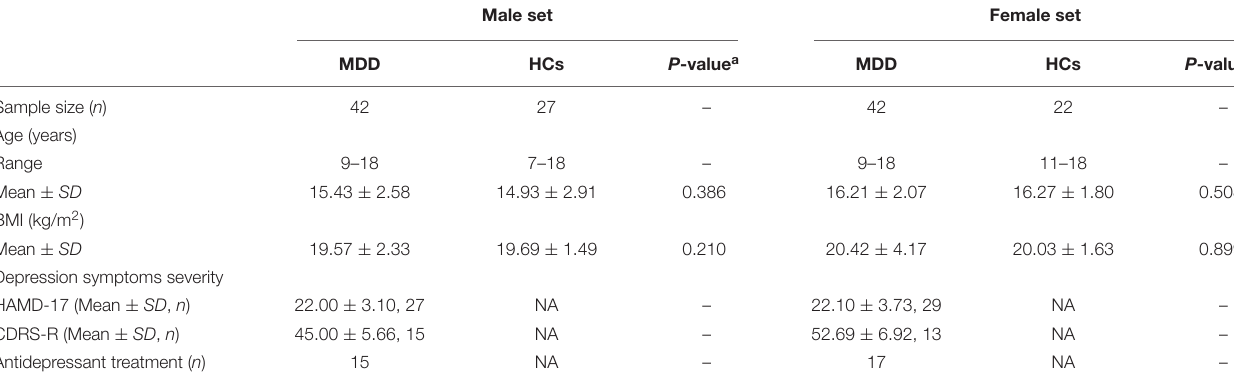
TABLE 1 | Clinical characteristics of the recruited patients with major depressive disorder and healthy